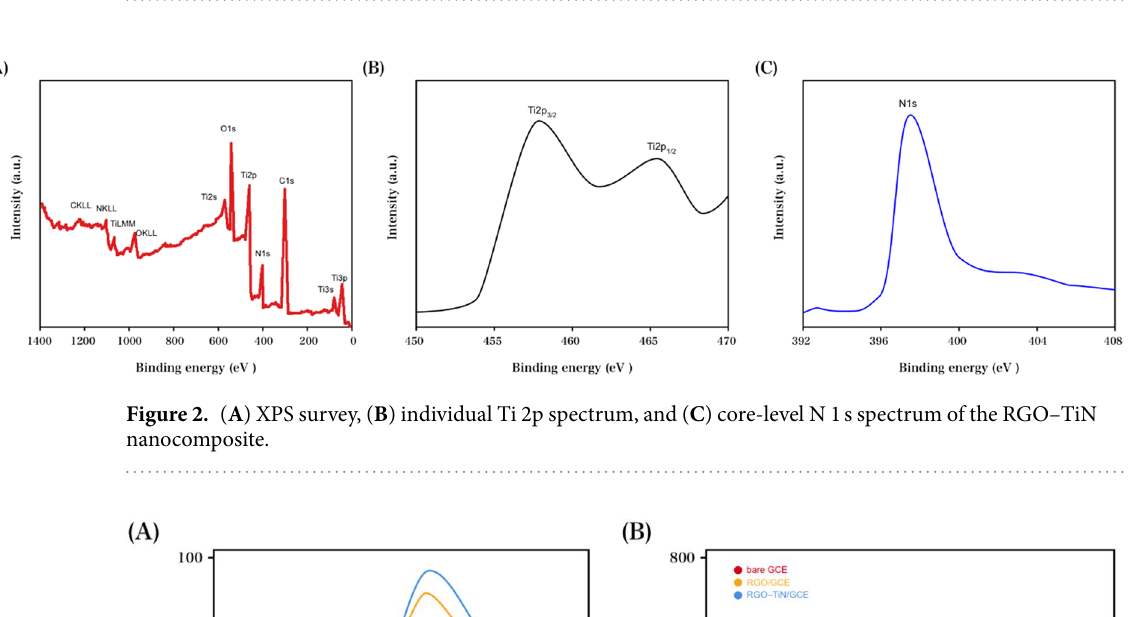
Figure 1. ( A ) Raman spectrum and ( B ) XRD profiles of the RGO–TiN nanocomposite.